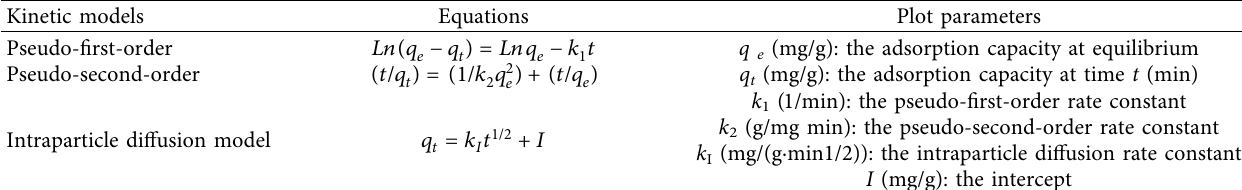
Table 2: The equations and their plot parameters of kinetic models.